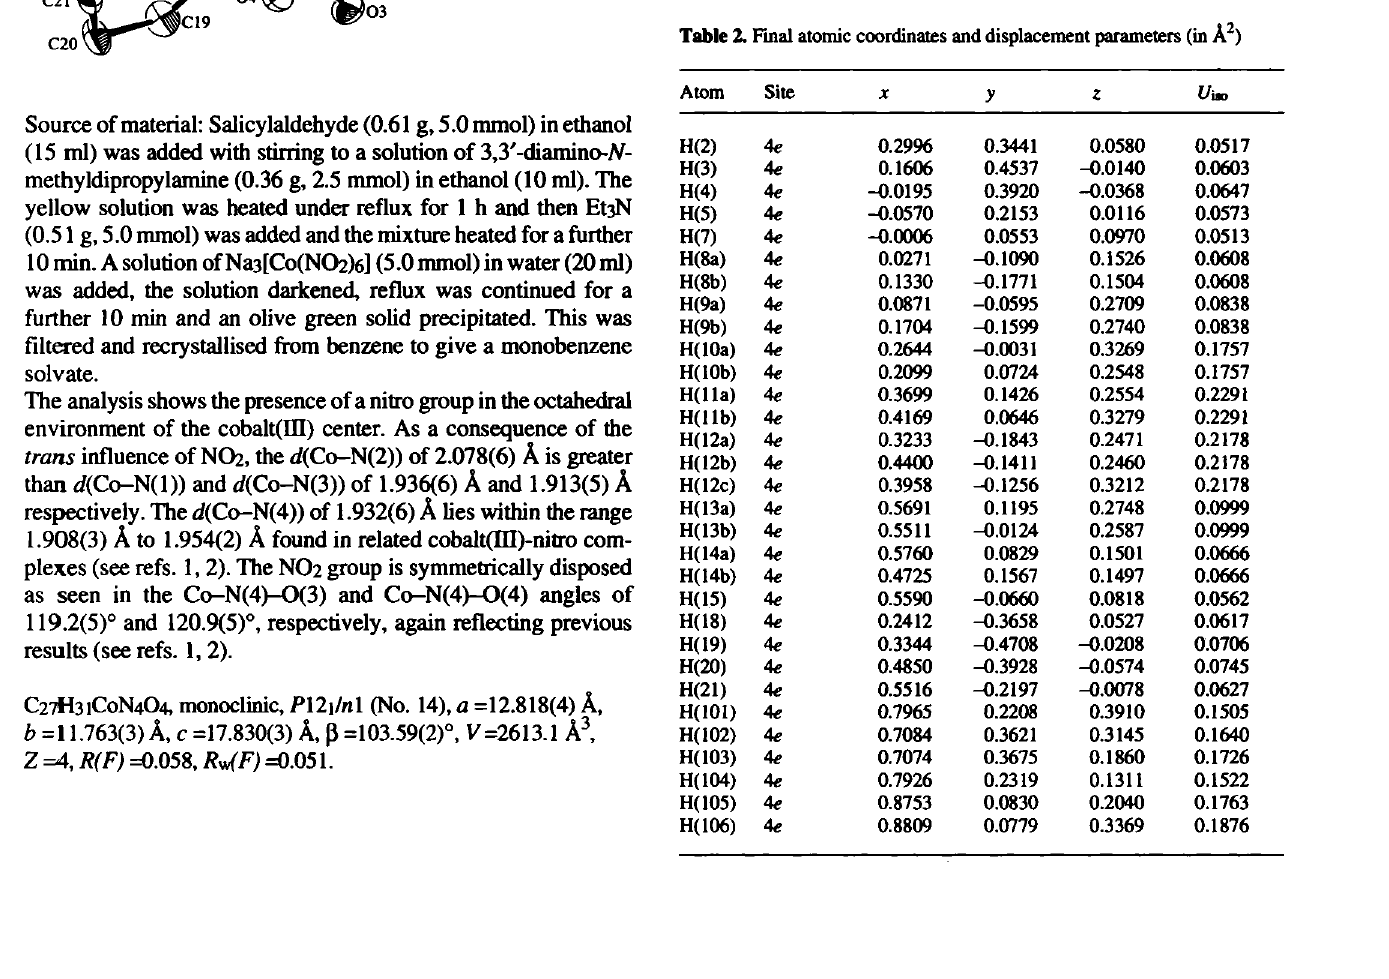
Table 2. Fmal atomic coordinates and displacement parameters (in